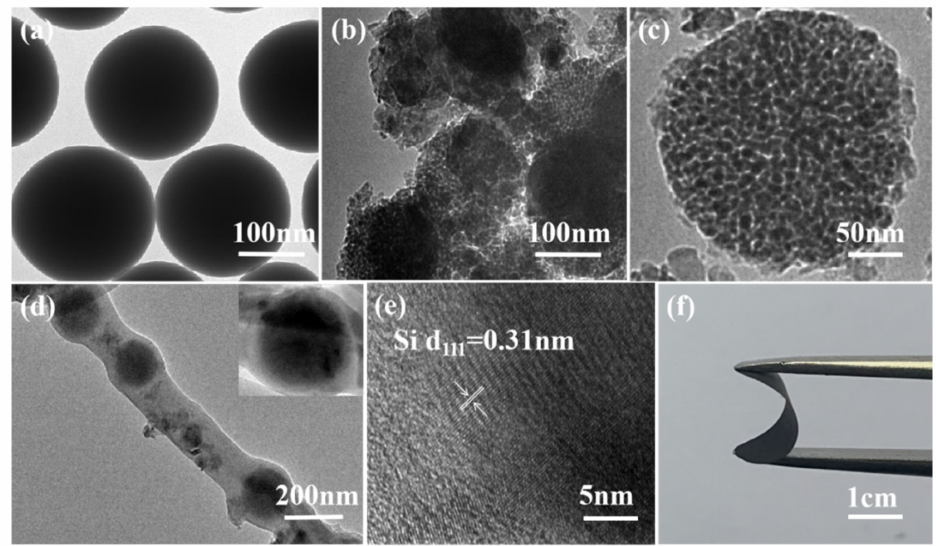
Figure 3. TEM images of ( a ) SiO 2 , ( b , c ) P − Si via the MR process, and ( d ) P − Si@CNFs − 150, ( e ) HRTEM image of P − Si@CNFs − 150, and ( f ) photo of the flexible P −